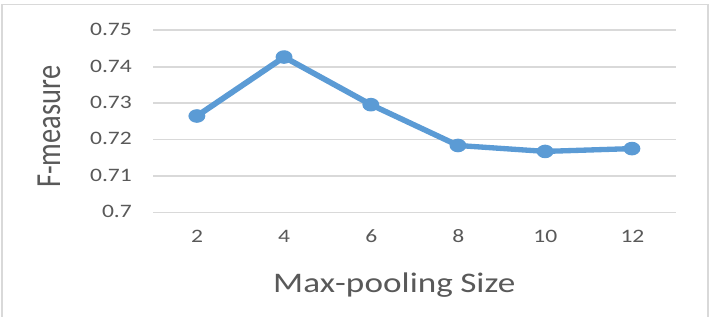
Figure 2. Dependency between the convolution filter size and the F-measure.